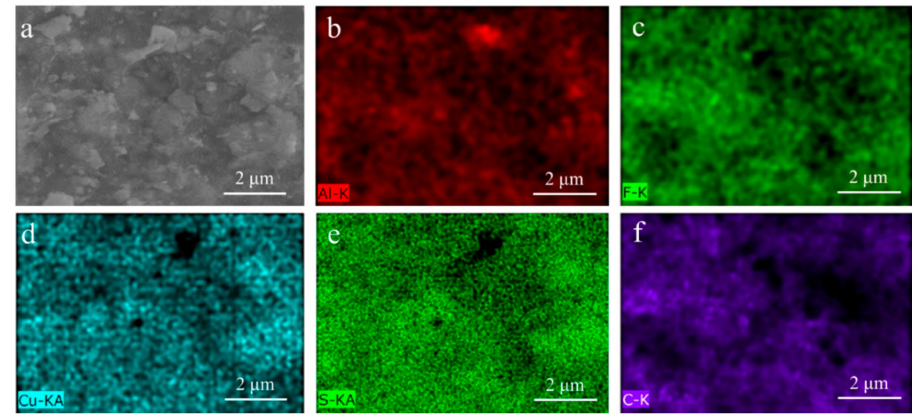
Figure 2. ( a ) SEM image of ALD-coated Cu 2 S@NG electrode with energy-dispersive X-ray (EDX) mapping of ( b ) Al, ( c ) F, ( d ) Cu, ( e ) S, and ( f ) C elements, exhibiting the uniformity of Al 2 O 3